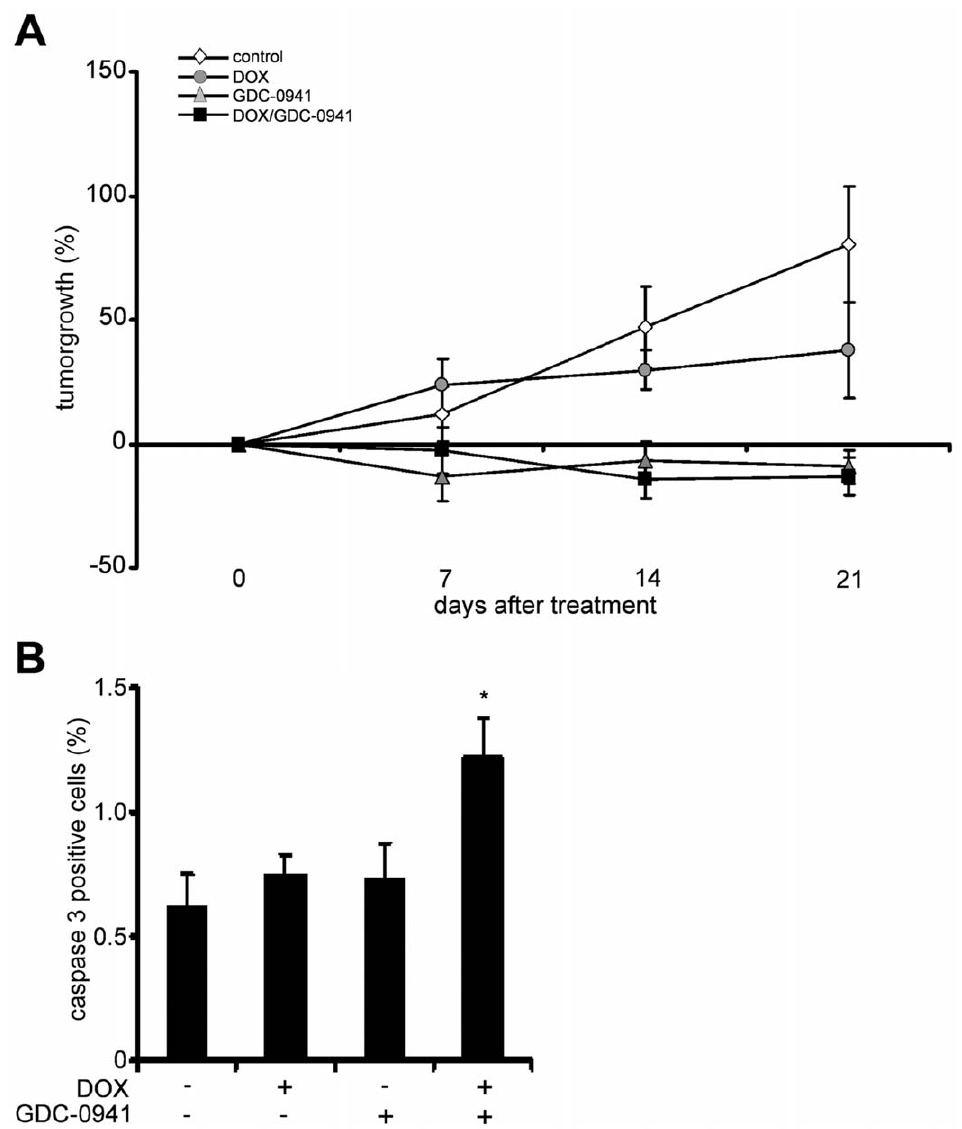
Figure S1 DOX plus PI103 results in induction of early and late apoptosis. Annexin V positive cells in the living cell fractions of the cell lines RD ( A ), TP5014 ( B ) and HT1080 ( C ) were distinguished according to the positivity of both Annexin V and PI.